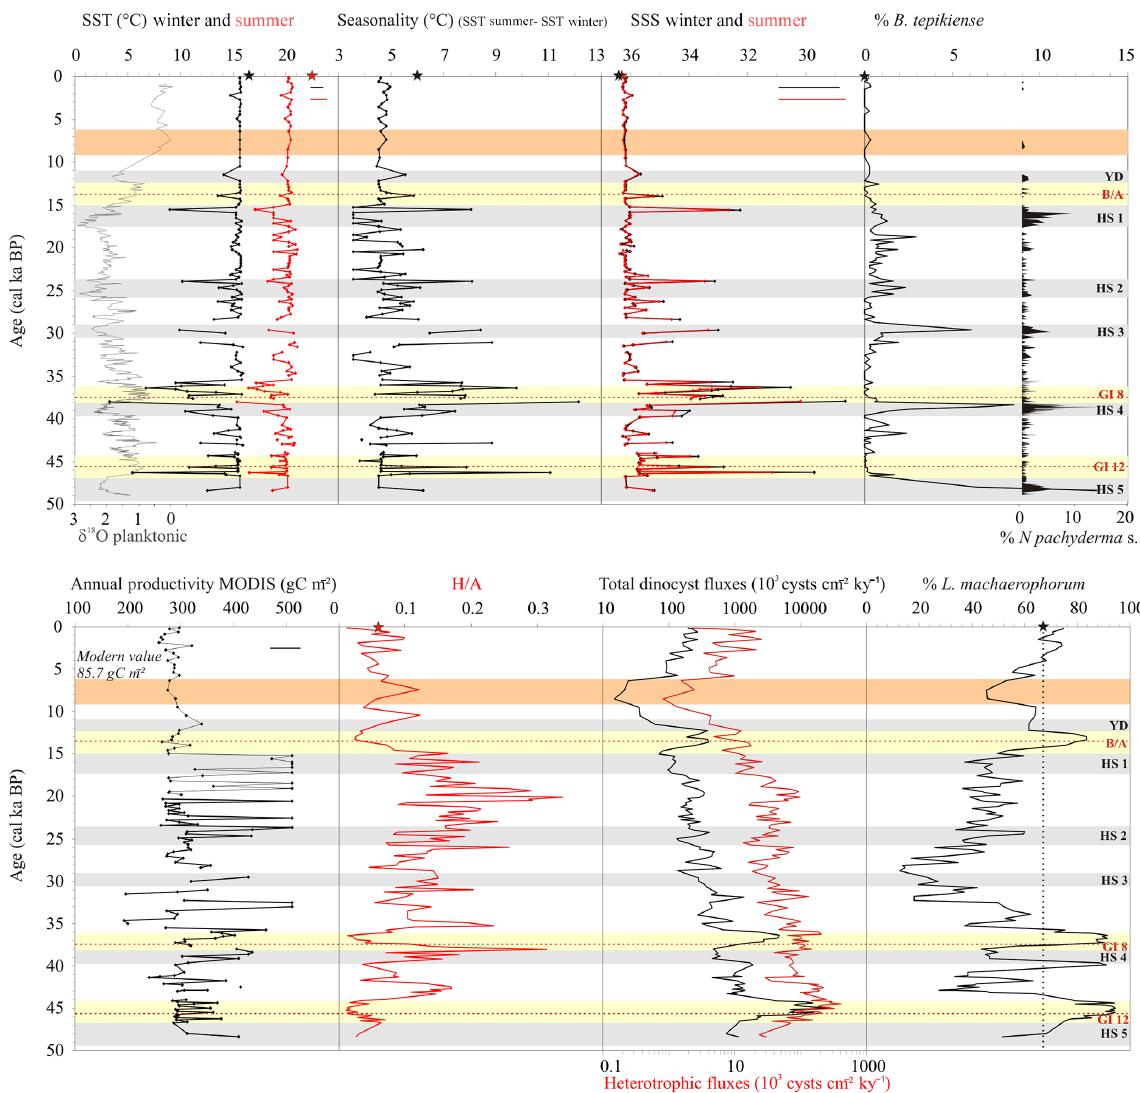
Figure 6. Data from core MD99-2339 against age (calkaBP). δ 18 O planktonic monospecific record and N. pachyderma (s.) percentages from core MD99-2339 (Voelker et al., 2006) in parallel with dinocyst transfer function results ( n = 1492; Radi and de Vernal, 2008): winter and summer sea-surface temperature (SST) and sea-surface salinity (SSS), as well as seasonality (SST summer–SST winter) and annual pro- ductivities. Total dinocyst and heterotrophic fluxes are also depicted with the ratio H/A for “heterotrophics/autotrophics”, and percentages of two species: L. machaerophorum as a species index for higher surface stratification linked with increased palaeo-river discharges and B. tepikiense as a species index for thermal seasonal contrasts. Stars on each graph indicate present-day values for dinocyst percentages and hydrological parameters recorded in modern sediments and overlying surface waters, respectively, at the coordinates of analogue “A184” in the modern dinocyst database (34.32 ◦ N, 7.02 ◦ W; http://www.geotop.ca/fr/bases-de-donnees/dinokystes.html): SST winter of 16.48 ◦ C and SST summer of 22.47 ◦ C, SSS winter of 36.35 and SSS summer of 36.33, mean annual productivity of 85.7gCm − 2 , and percentages of L. machaerophorum of 65.27% and B. tepikiense of